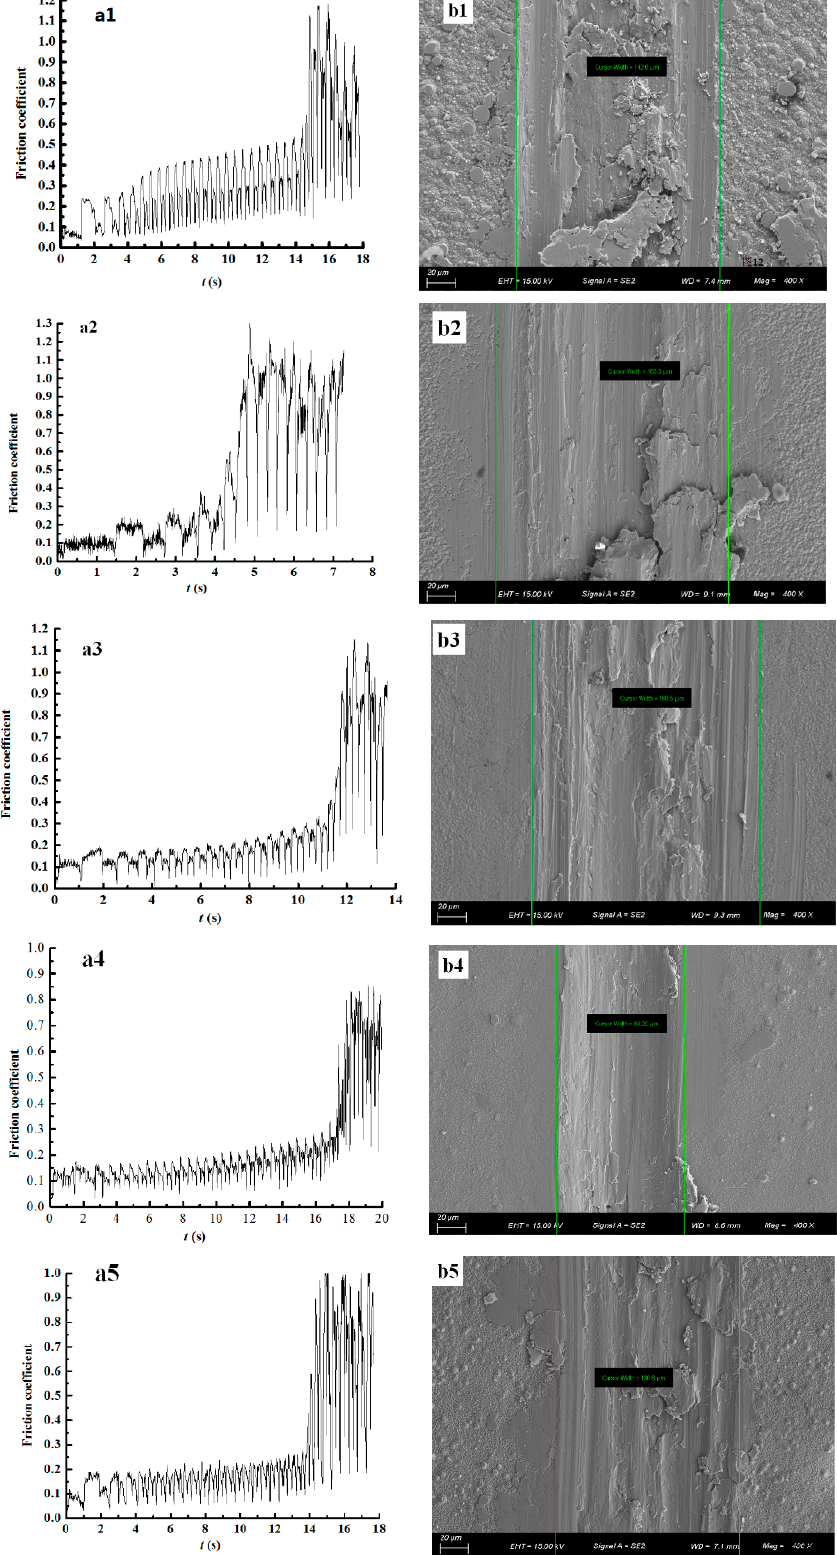
Figure 12. The abrasion resistance of coatings. ( a ) The friction factor and ( b ) corresponding SEM images of wear scar width. The numbers 1 to 5 represent that the concentration of the nanodiamond particles in the plating solution is 0, 0.8, 4.0, 8.0, and 16.0 g/L, respectively.